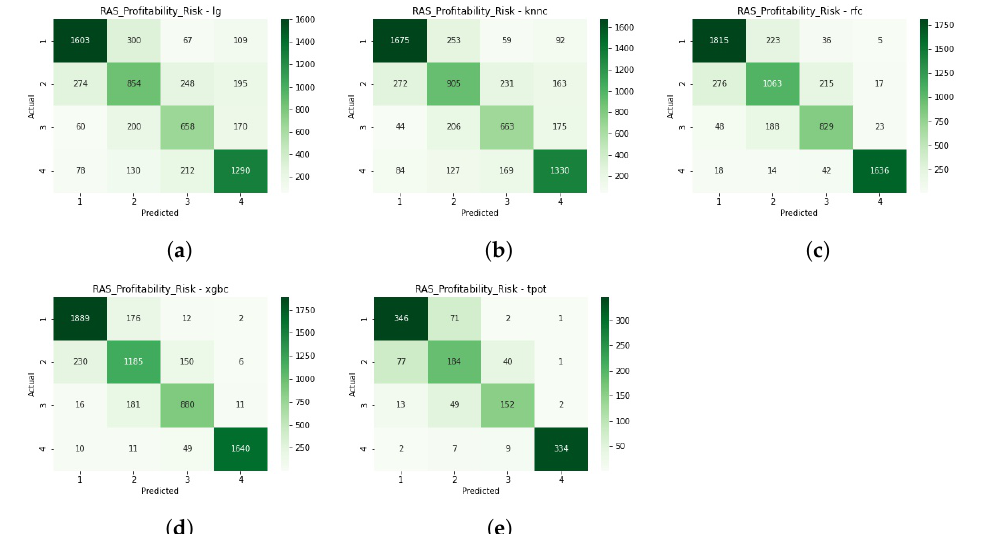
Figure A8. Profitability risk: confusion matrices generated when evaluating the above-mentioned models, using cross-validation approach. ( a ) Logistic Regression. ( b ) k-Nearest Neighbours clas- sifier. ( c ) Random Forest classifier. ( d ) Extreme Gradient Boosting classifier. ( e ) TPOT classifier autoML